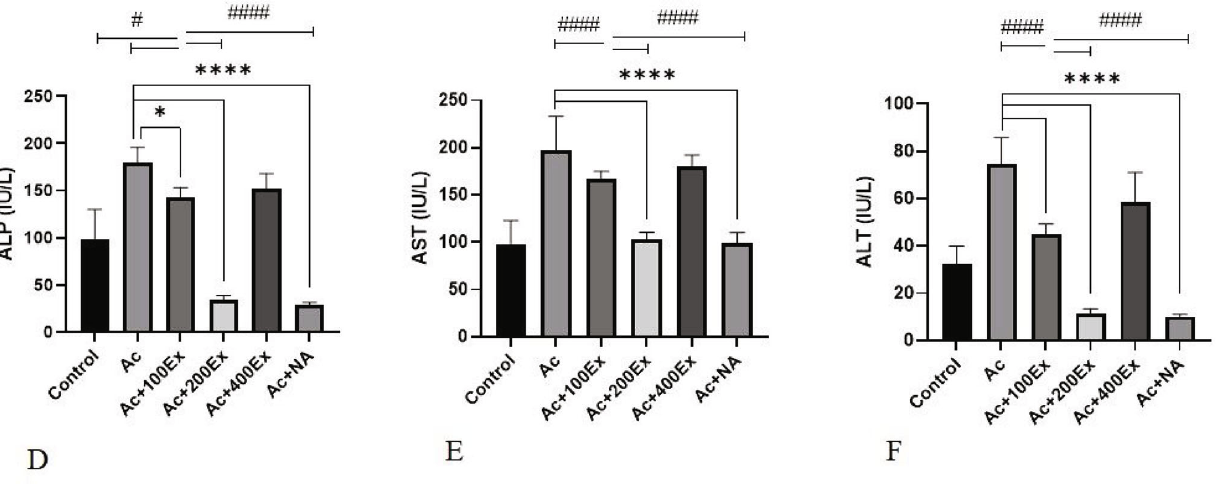
Figure 2: Di ff erent changes of liver enzymes in the studied groups. **** Di ff erence between control and Ac groups with other groups ( P < 0 : 001 ). #### Di ff erence between treatment groups with each other P ≤ 0 : 001 . # Di ff erence between control group with other groups ( P < 0 : 05